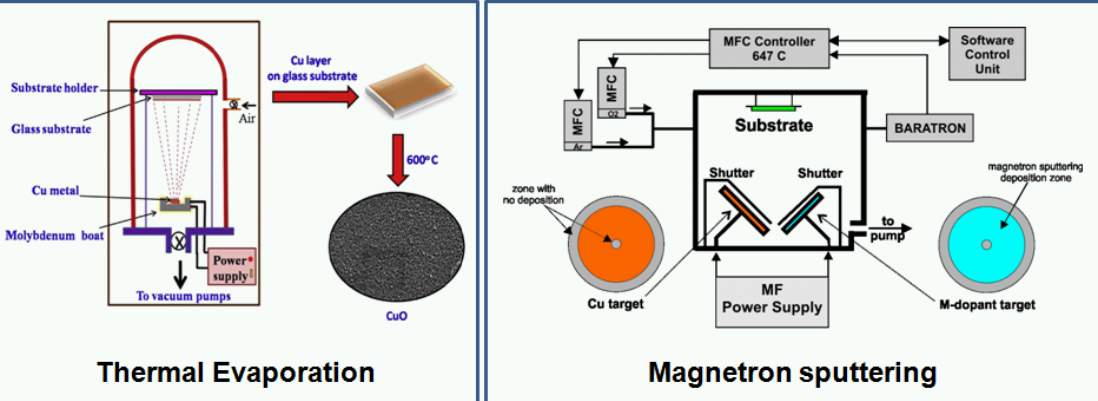
Figure 2. Cont. Figure 2.